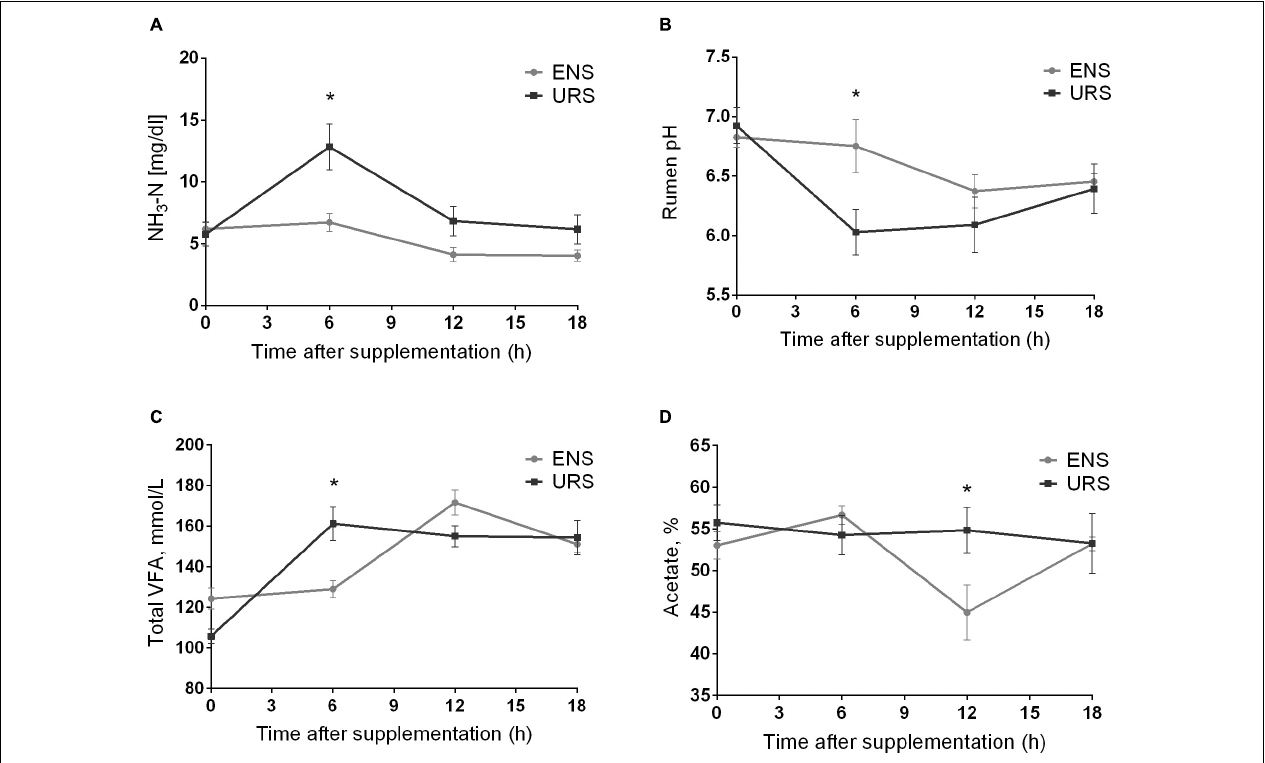
FIGURE 1 | Mean and standard error of mean of ruminal ammonia (NH 3 -N) concentration (A) , pH values (B) , total volatile fatty acid (VFA) rumen concentration (C) and Acetate proportions (D) during a 18 h period in grazing Nellore Steers after a long time (13 months) of supplementation with encapsulated nitrate (ENS) or Urea (URS). ∗ supplement effect and time effect interaction ( P < 0.05) as obtained with Tukey’s